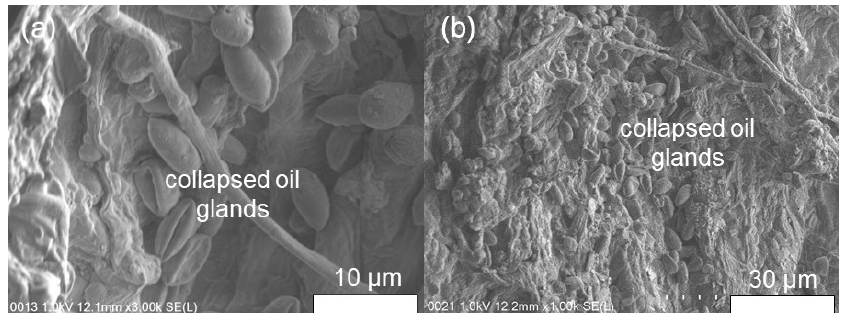
Figure 8. The SEM images of the A. calamus residue after the solvent extraction process. Both images ( a ) and ( b ) shows the collapsed oil glands at different magnifications after the active compound is extracted. Image ( a ) was taken at 3000× magnification and image ( b ) at 1000× magnification.